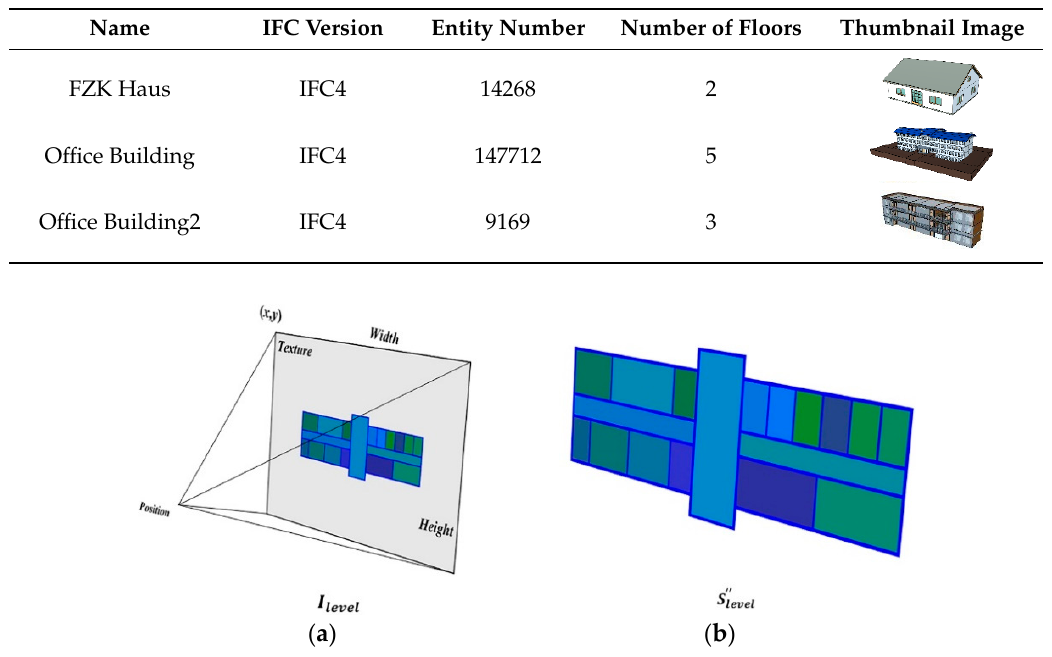
Table 2. Experimental data.